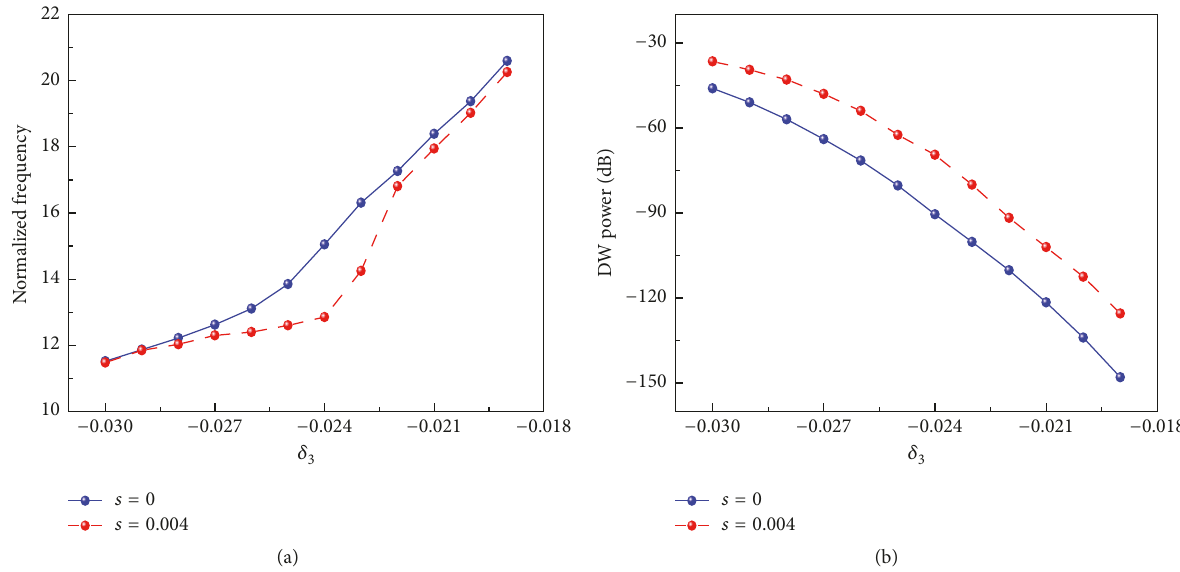
Figure 4: Central frequency (a) and relative average intensity (b) of the blue-shift DW plotted as a function of TOD coefficient 𝛿 3 , where 𝑠 = 0 (blue filled circles lines) and 𝑠 = 0.004 (red dashed circles